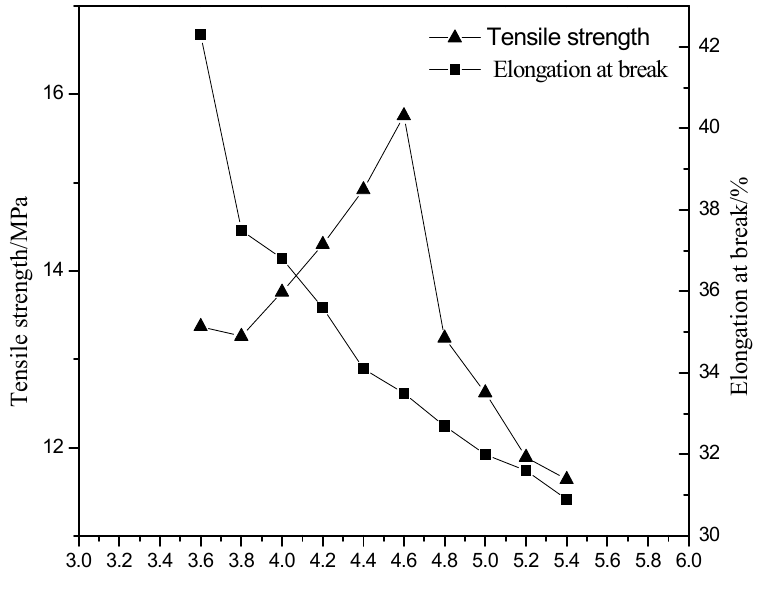
Figure 7. Effect of the amount of hydroxy silicone oil on tensile strength and elongation at break.